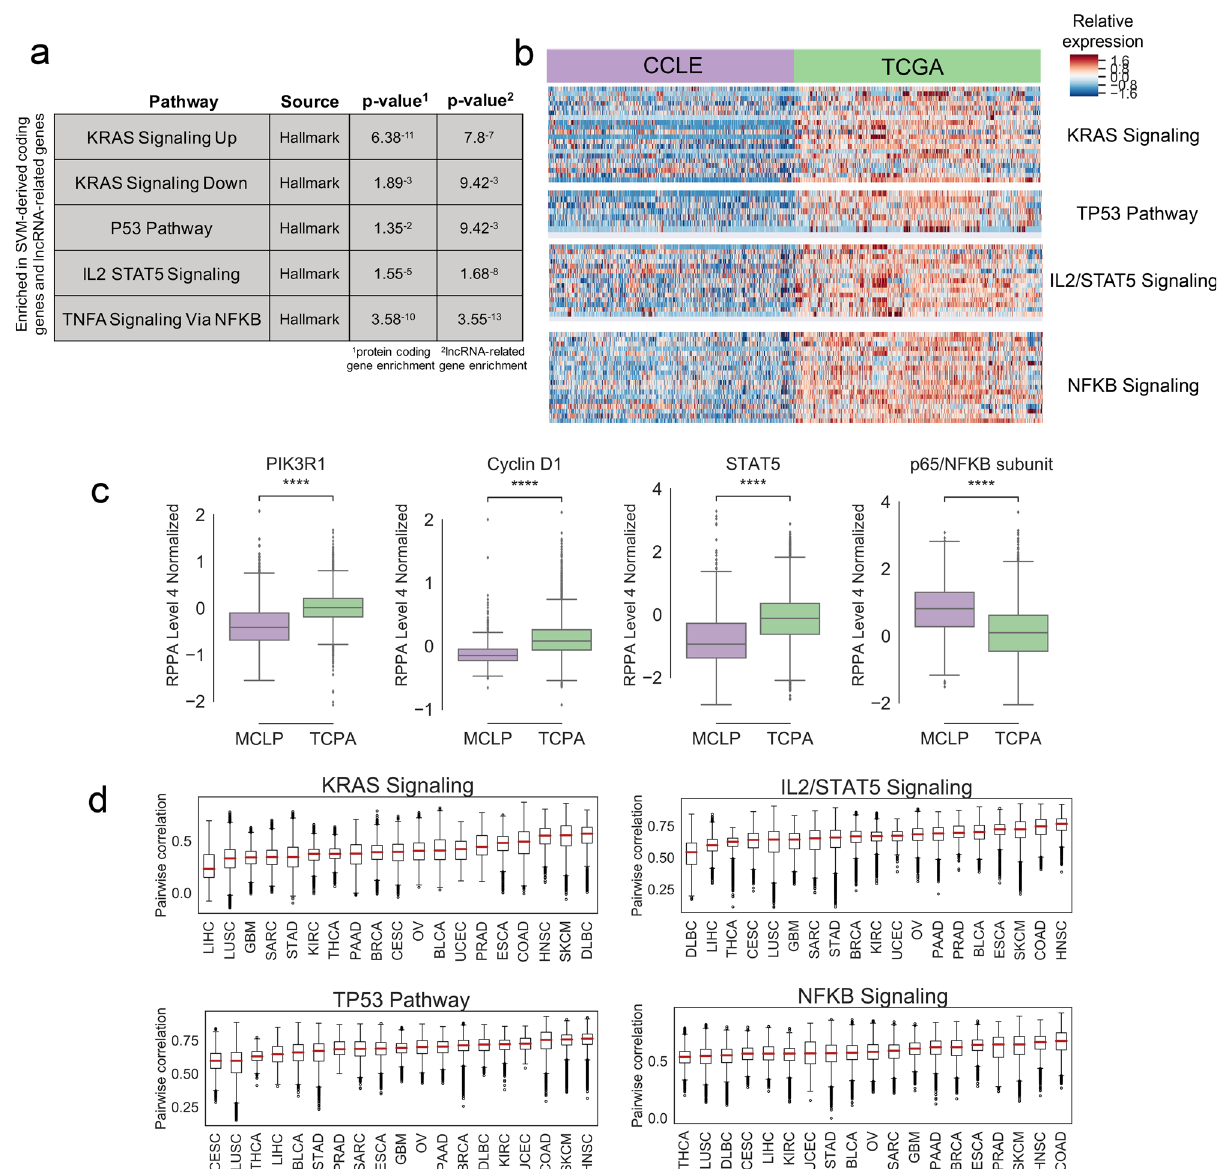
Fig. 2 KRAS signaling, TP53 pathway, IL2/STAT5 signaling, and NFKB signaling are signi fi cantly enriched for genes with reduced expression in CCLE compared to TCGA. a GSEA results for the cancer driver pathways which overlap with SVM-derived genes. P values are shown for the signi fi cance of gene overlap with SVM-derived protein-coding genes, and for genes linked by miRNet to SVM-derived lncRNA. b Heatmaps showing expression of SVM- identi fi ed genes in four cancer driver pathways in TCGA compared to CCLE. The samples shown are a random subset with equal representation from each dataset in each disease. c Boxplots showing overall protein quanti fi cation of representative proteins from each of the four cancer driver pathways in TCPA ( n = 5607) and MCLP ( n = 646) datasets (two-sided Mann – Whitney signi fi cance test; * P value < 0.05, ** P value < 0.01, *** P value < 0.001). d Boxplots show pairwise Spearman correlation scores between all CCLE and TCGA RNA-seq samples in each disease type, for all four cancer driver pathways. Plots are sorted by mean